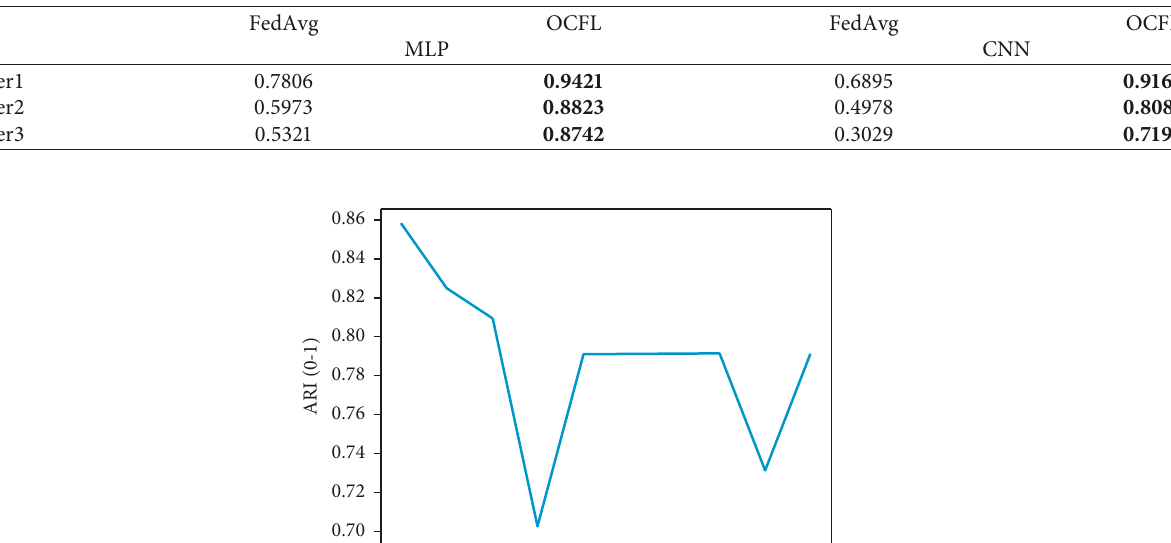
Figure 5: Mnist data set clustering experiment (rounds � 500, η � 0.000005, frac � 0.1, (E) � 1, (B) � 10. Left is the result of MLP, right is the result of CNN). Table 3: Model test accuracy on Mnist.